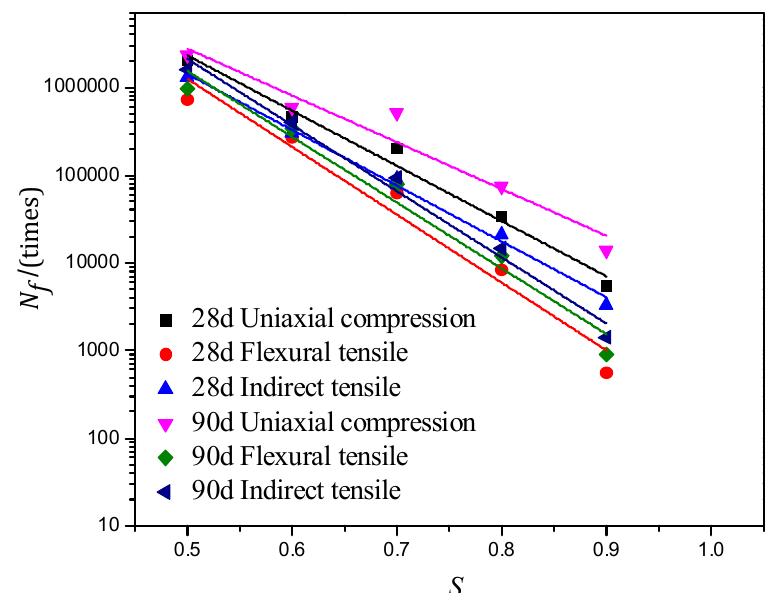
Figure 6. Fitting curve for the fatigue equation for a cement content of 3% under different stress states.